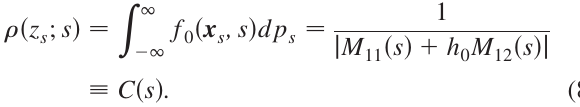
¼ (cid:1) 8 deg , and (cid:2) 0